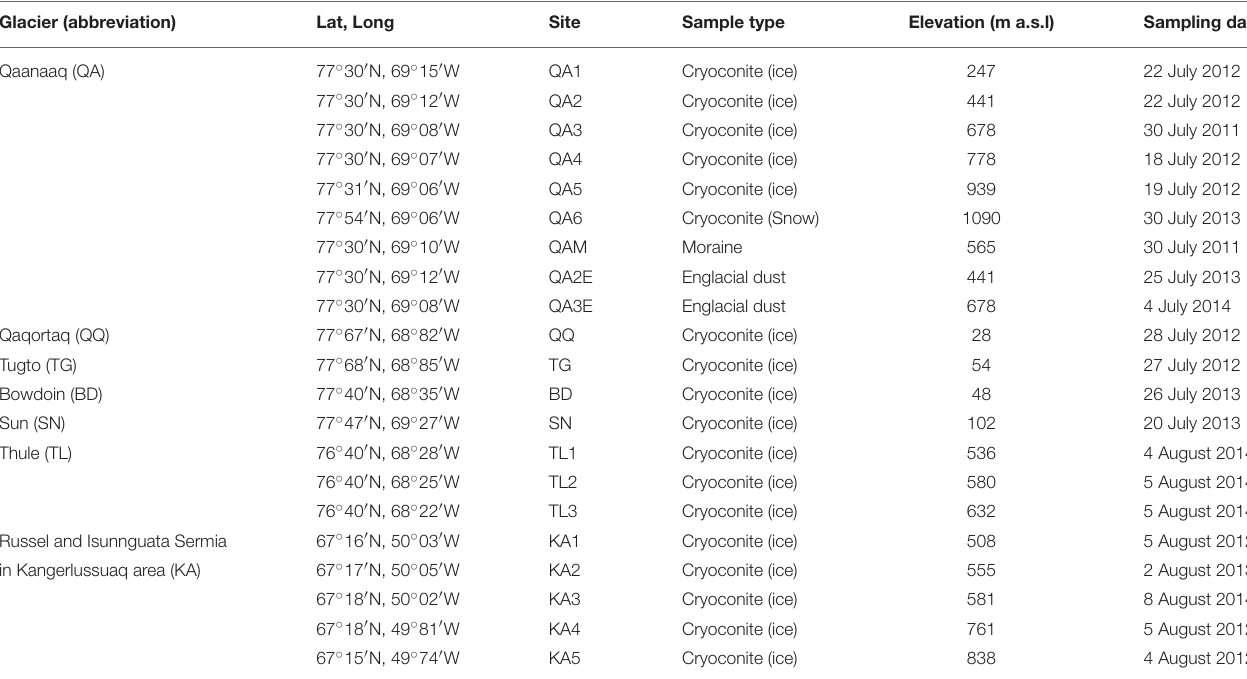
TABLE 1 | Description of sample of cryoconite, moraine, and englacial dust on and around the glaciers in northwestern and southwestern Greenland. Glacier (abbreviation) Lat, Long Site Sample